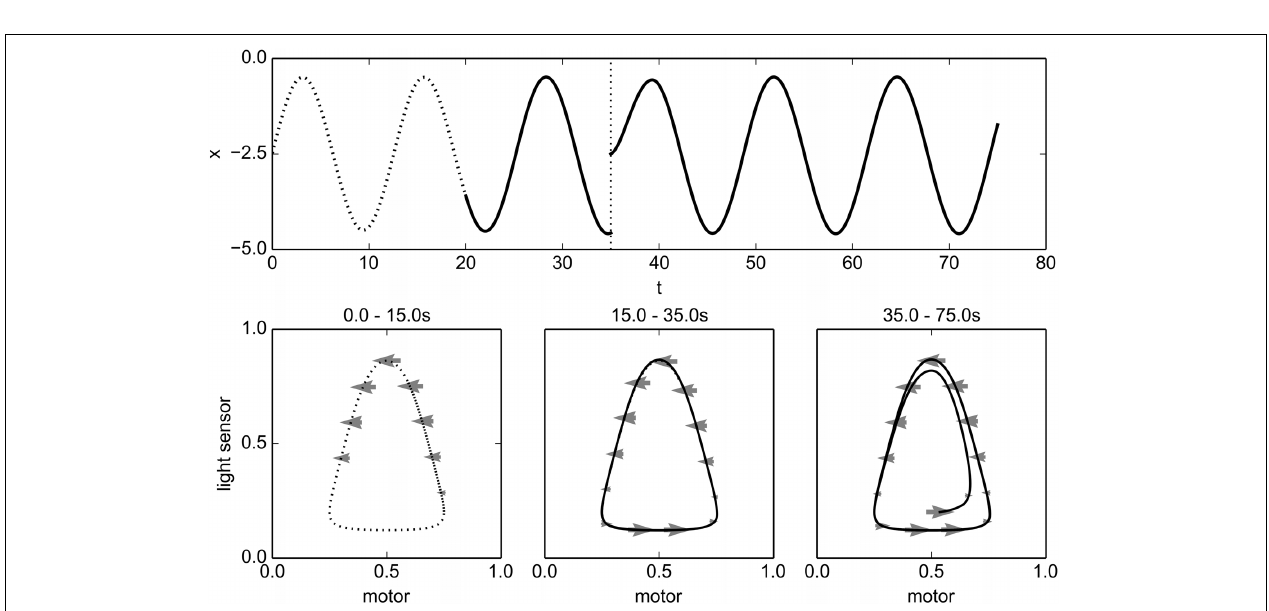
the combination of the two. In the final plot, a randomly selected initial condition (star) is shown to have a trajectory (blue curve) that approaches the trained cycle of motor activity (gray circle).